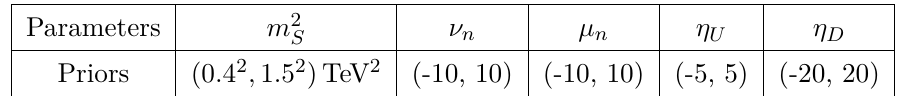
Table 1 . Prior values of the fitted